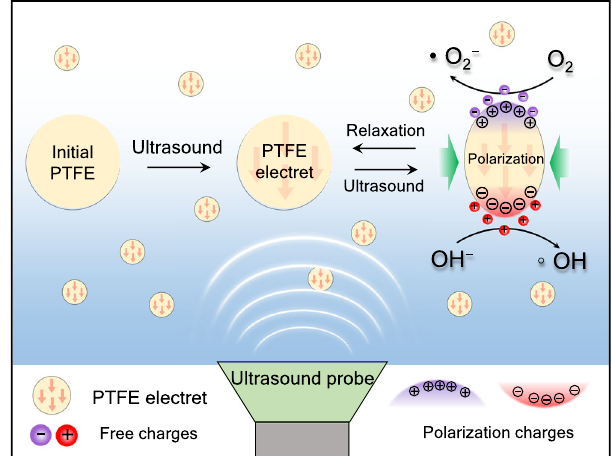
Fig. 1 Schematic illustration of the piezocatalytic generation of ROS by PTFE under ultrasound irradiation. The initial PTFE was fi rst activated to become a permanent polarized piezoelectric PTFE electret under ultrasonic irradiation. Then the charges from the surrounding electrolyte were adsorbed on the surface of PTFE. Subsequently, the adsorption of charges will be released as free charges under compressive stress and interact with water molecules or oxygen to produce homogeneous